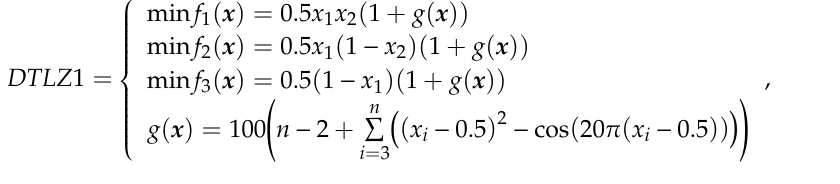
Figure 7. Filling the path between x ∗ and X i . ( a ) Design space. The red five-pointed star is X i and the black dots are the path between x ∗ and X i . ( b ) Objective space. The red star is the corresponding representation of X i in the objective space, and the black dots are the corresponding representation of the path in the objective space.